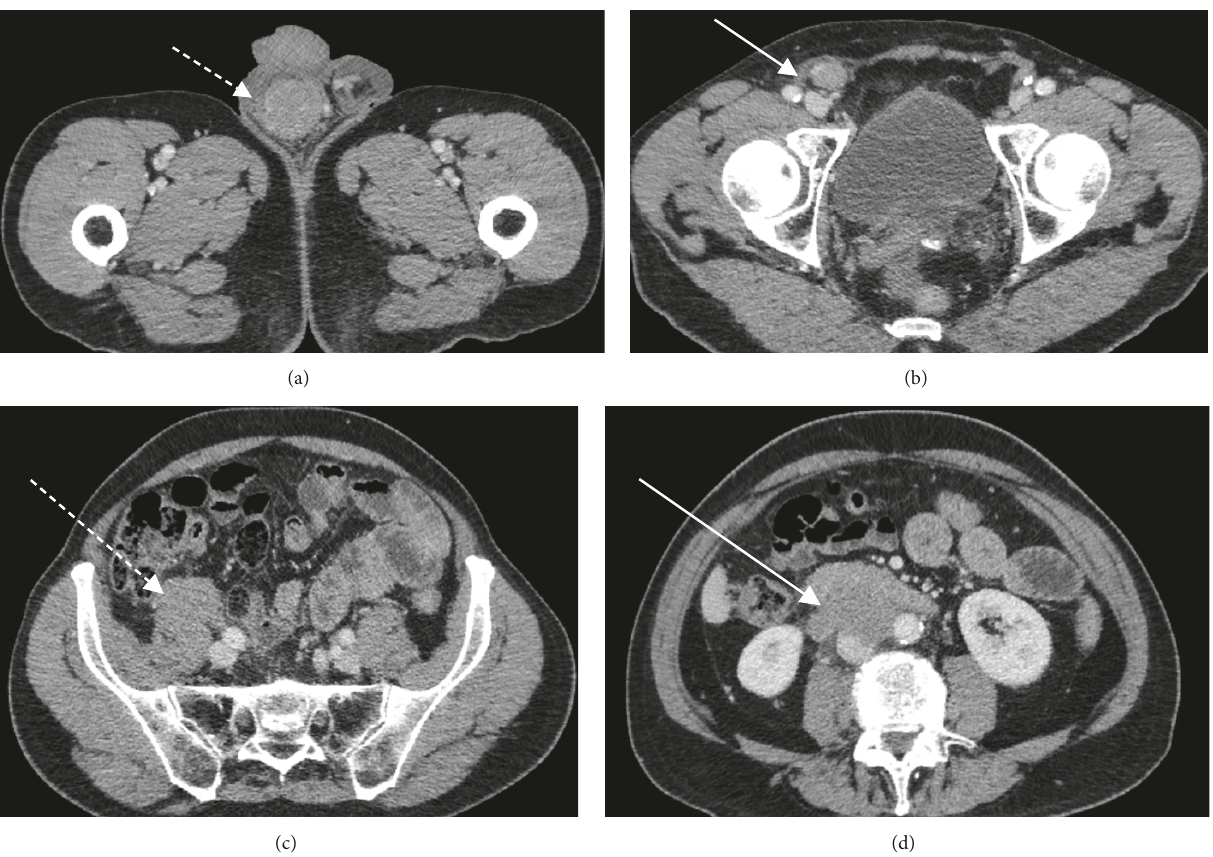
Figure 2: (a) Axial CT image with contrast at the level of the scrotum demonstrates a right testicular mass (dashed white arrow). (b) Axial CT image with contrast at the level of the inguinal canal demonstrates superior tumour infiltration along the right spermatic cord (white arrow). (c) Axial CT image with contrast at the level of the common iliac vessels demonstrates tumour extension along the right gonadal vein (dashed white arrow). (d) Axial CT image with contrast at the level of the kidneys demonstrating confluent aortocaval soft tissue at the site of gonadal vein insertion into the IVC (white